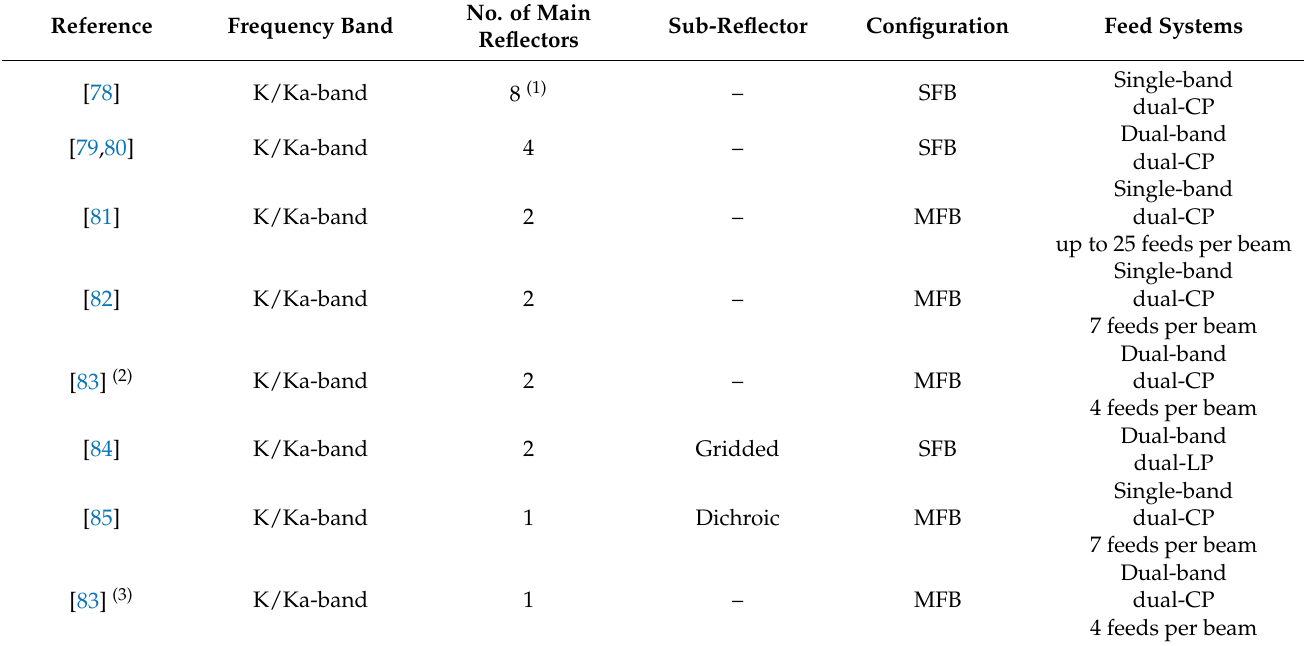
Table 4. Evolution of broadband satellite antenna